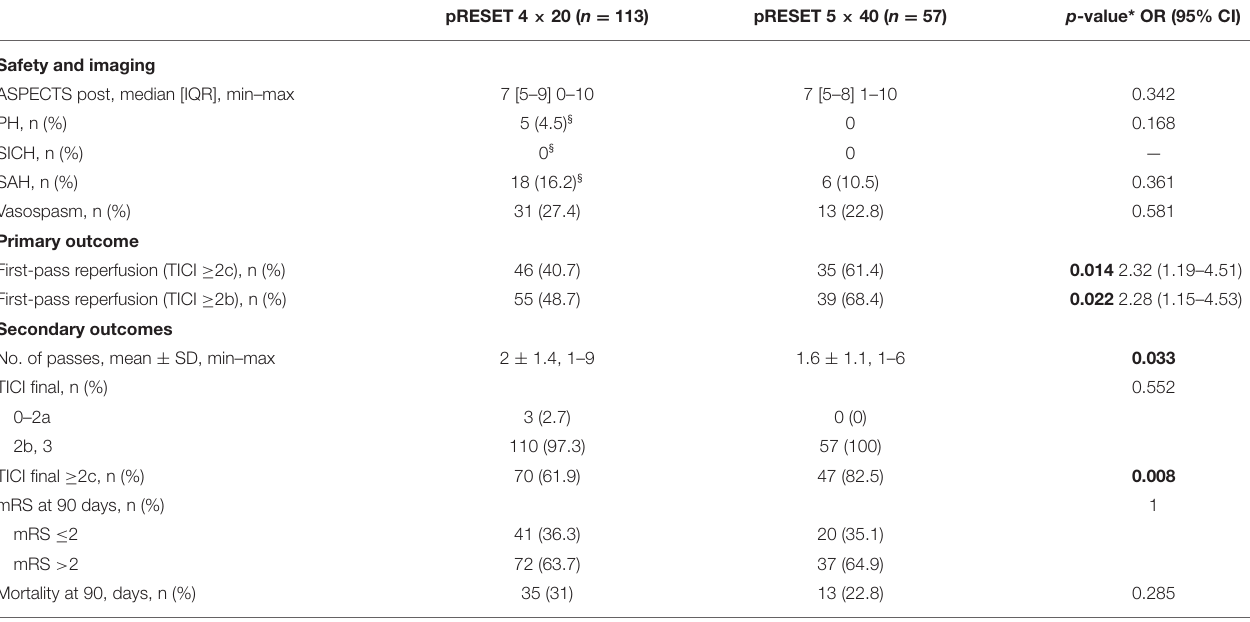
TABLE 2 | pRESET 5 × 40 vs. pRESET 4 × 20 in M1 occlusions: safety parameters and clinical and angiographic